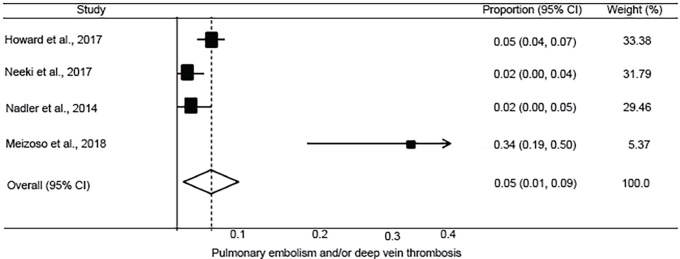
Forest plot of the incidence of pulmonary embolism and/or deep vein thrombosis after tranexamic acid use in injured adults.CI, confidence interval.Chi-square=23.19 p<.0001; I2=87.1%.